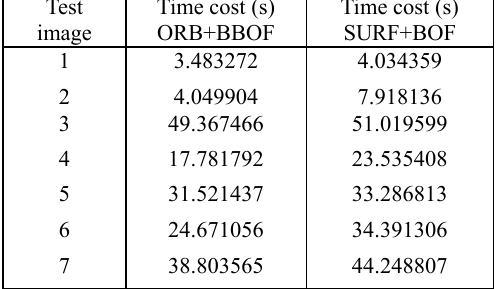
Table 1 Comparison of time